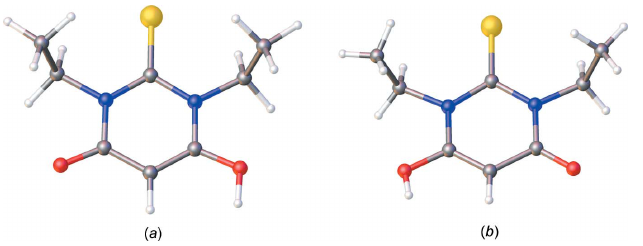
Crystal data Chemical